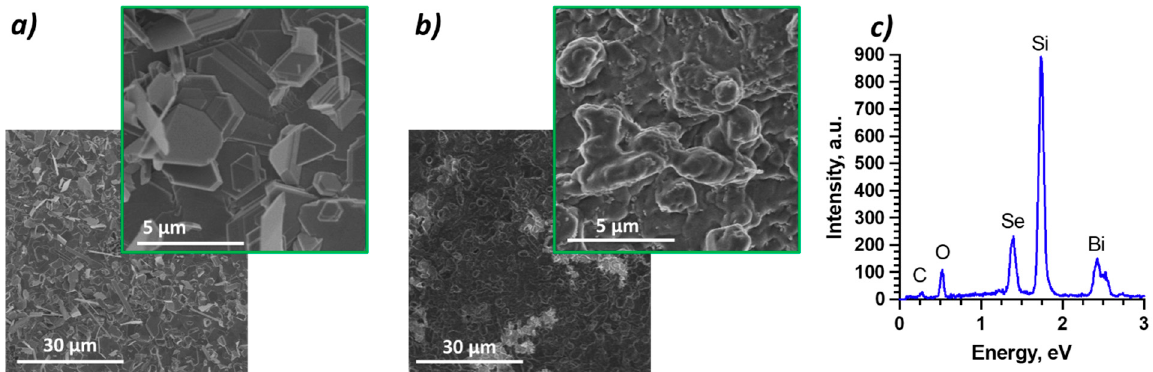
Figure 2. ( a ) SEM image of a fresh Bi 2 Se 3 thin film; ( b ) SEM image of a fresh Bi 2 Se 3 thin film after 5 CV cycles at scan rate 1.0 mVs − 1 ; ( c ) EDX spectra of a fresh sample. 5 CV cycles at scan rate 1.0 mVs − 1 ; ( c ) EDX spectra of a fresh sample. Table 1. Quantitative EDX analysis before cycling and after 5 CV cycles at 0.25 mV · s − 1 and after 30 CV cycles at 1 mV · s − 1 . σ —standard